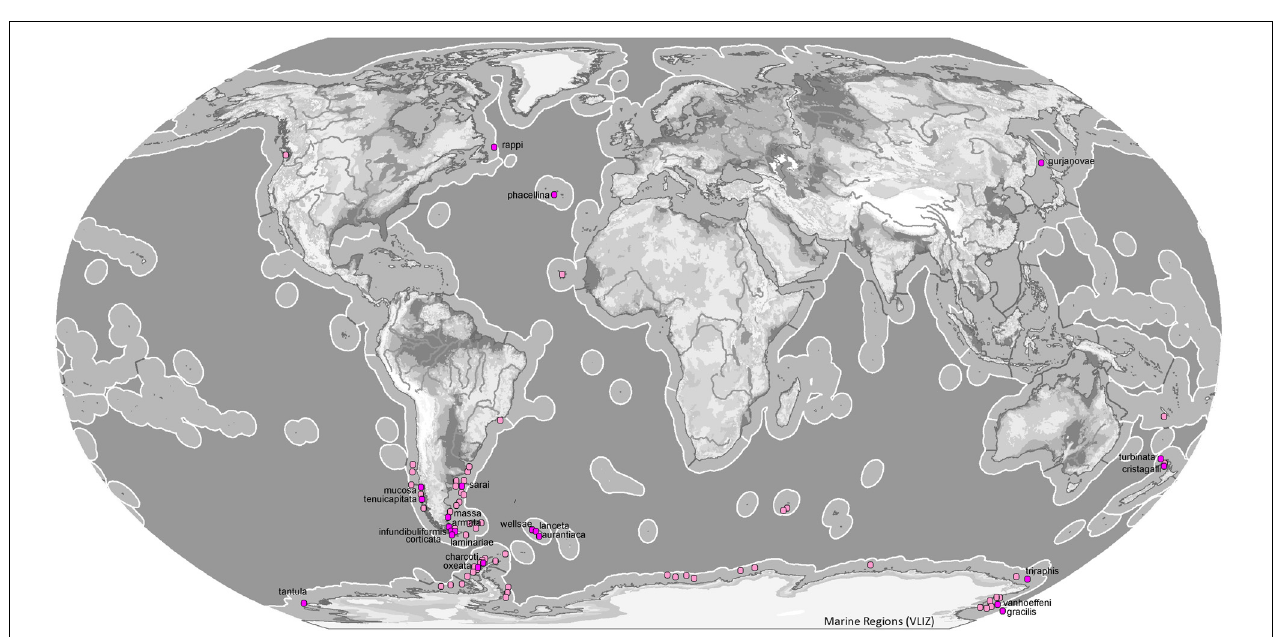
FIGURE 9 | Map of ecoregions (Spalding et al., 2007) showing the global diversity and distribution of the subgenus Tedaniopsis (purple dots for holotypes, pinks dots for other records) based on data derived from the World Porifera Database 2020 combined with the new data from the present study.